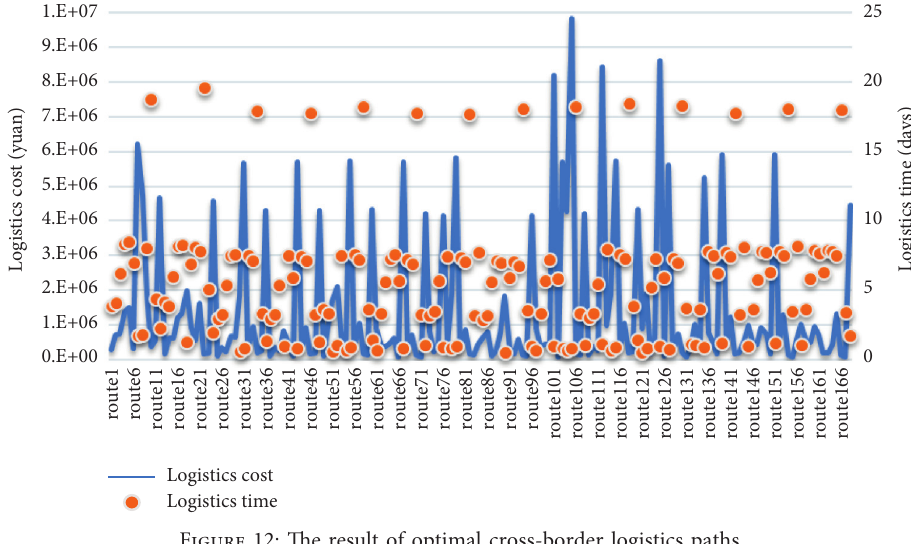
Figure 12: The result of optimal cross-border logistics paths. Table 6: The comparison of transportation proportions for optimal cross-border logistics paths based on bi-objective optimization. The result of optimal